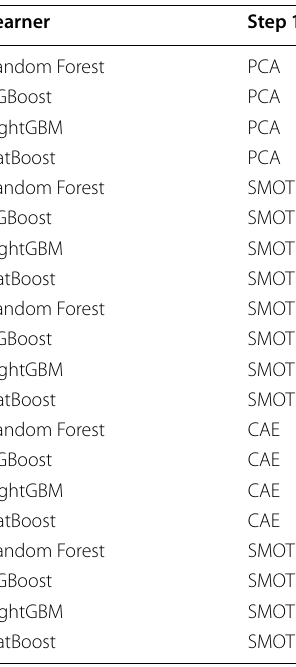
Table 8 Performance scores for SMOTE